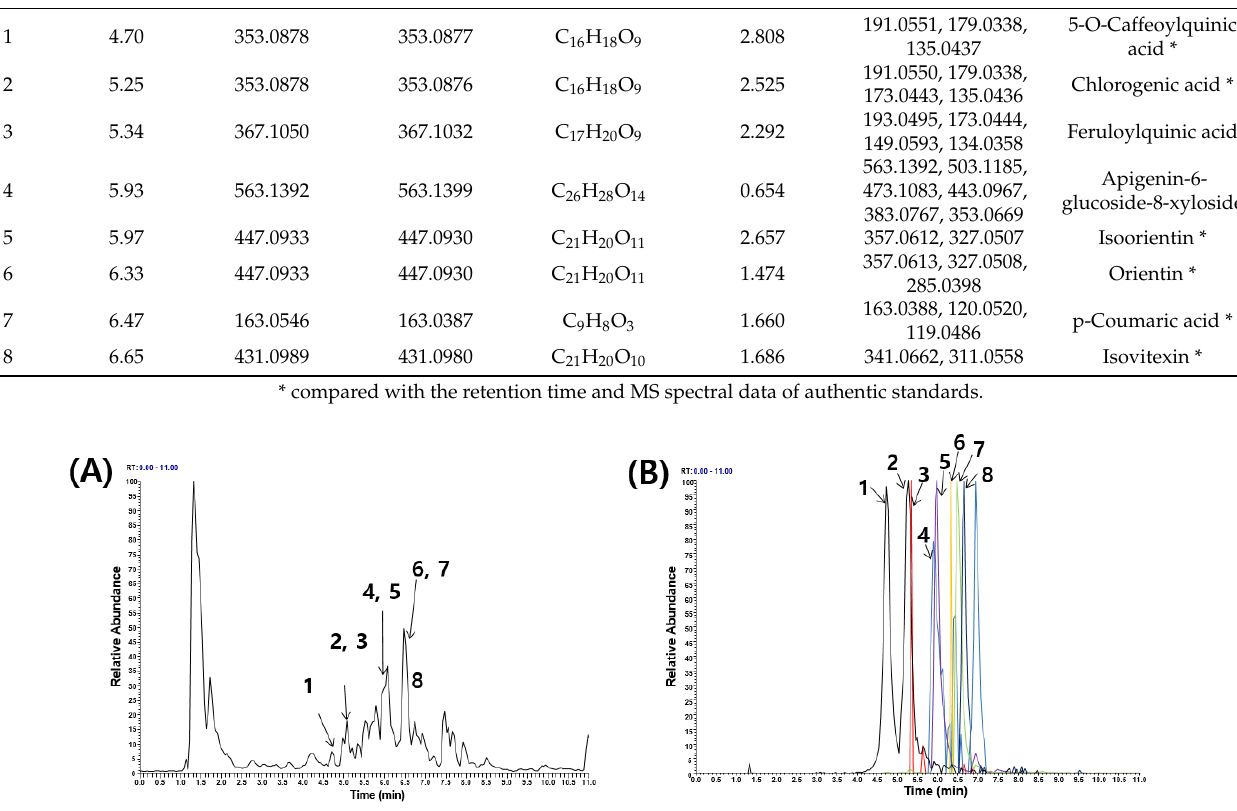
Figure 6. UHPLC – MS/MS analysis of WELG. ( A ) Base peak chromatogram in negative ion mode. ( B ) Extracted ion chromatogram of identified phytochemicals. 1, 5-O-caffeoylquinic acid; 2, chloro- genic acid; 3, feruloylquinic acid; 4, apigenin-6-glucoside-8-xyloside; 5, isoorientin; 6, orientin; 7, p- coumaric acid; 8, isovitexin.